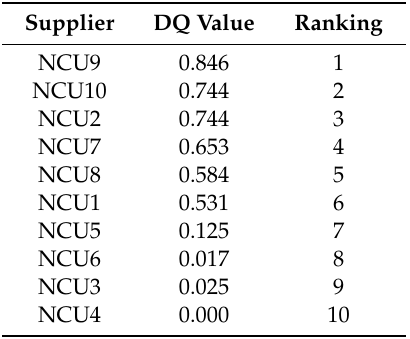
Table 11. Ranking of supplier compromises by value Q i